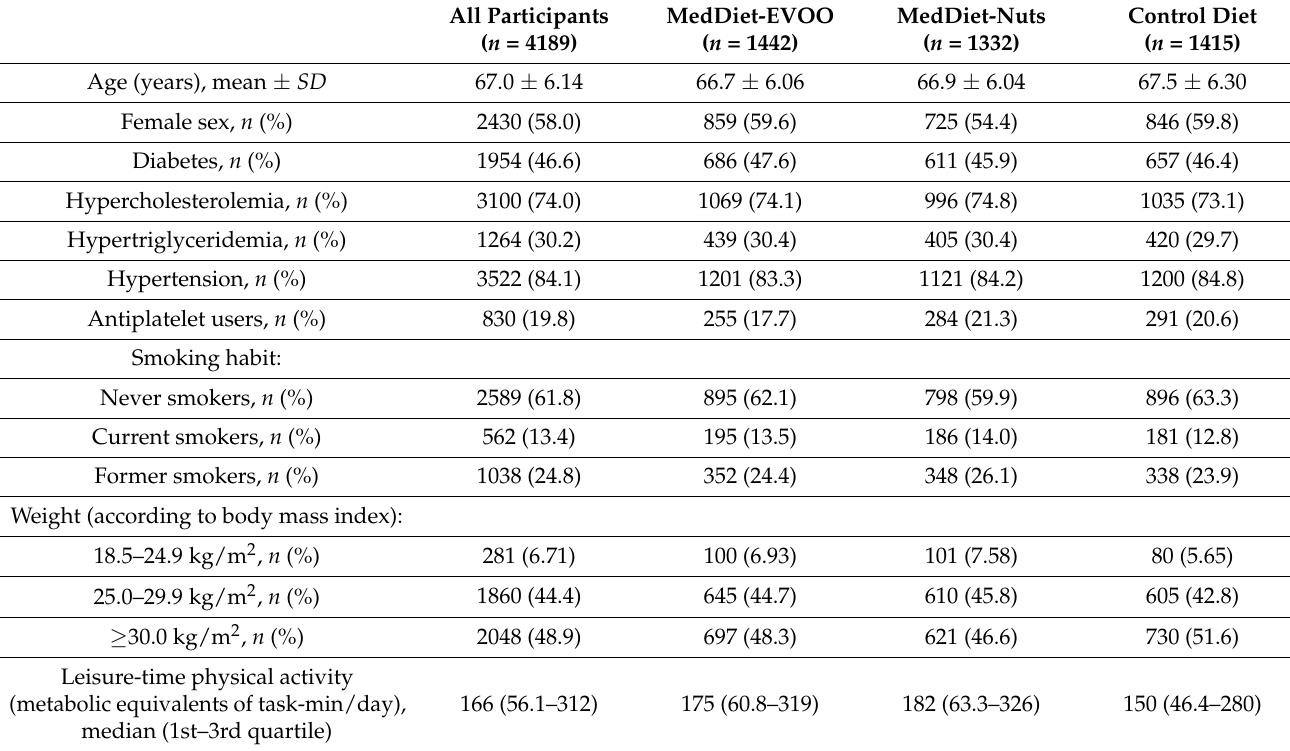
Table 1. Study population 1